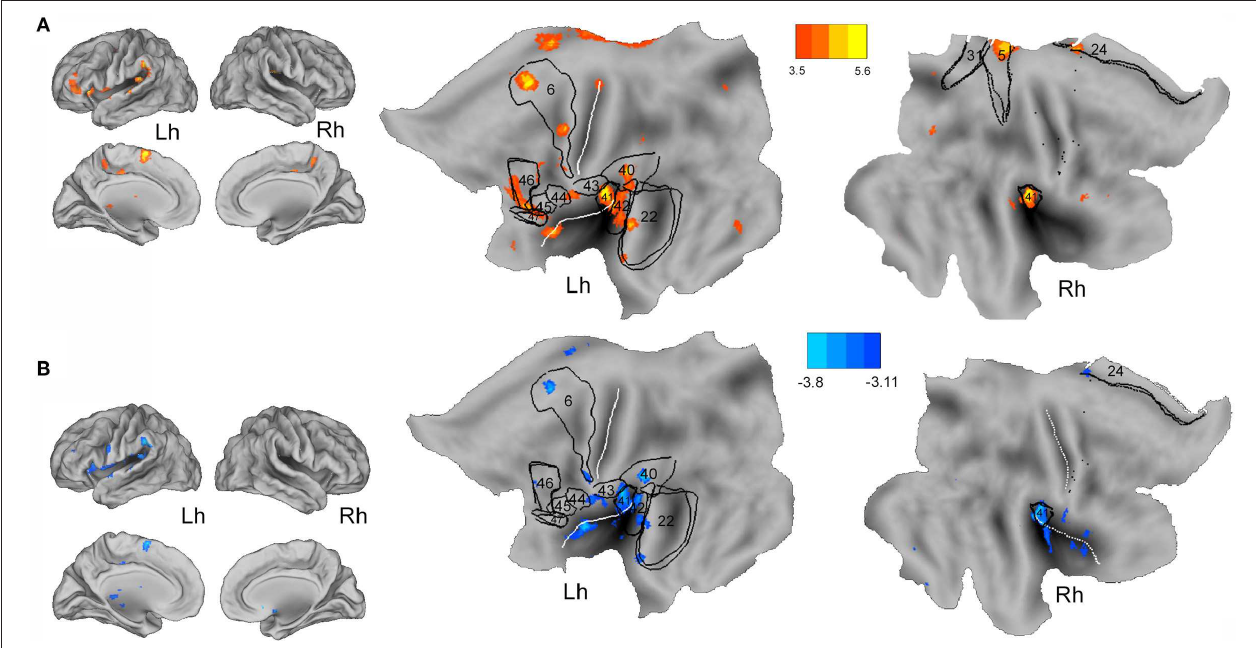
FIGURE 3 | Whole-brain correlation analysis between CTS density-related BOLD changes and disease’s duration (A) and age at fMRI (B) are warped to the PALS-B12 atlas in caret (lateral and mesial view) for right (Rh) and left (Lh) hemisphere and to flat template. See text for details. For localization purposes, functional results were plotted and compared against Brodmann areas indicated by the black numbers. The white lines on the PALS-B12 atlas and flat template show the central and sylvian fissure surface landmarks as implemented in Caret. The yellow-red color identifies the positive correlations, the light-blue color the negative correlations.